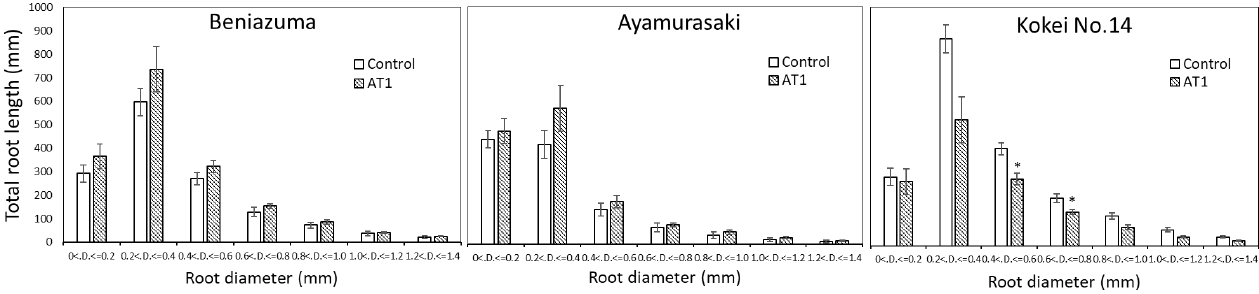
Figure 1. Effect of Bradyrhizobium sp. AT1 inoculation on root length of three cultivars of sweet potato. The length is shown separately for different diameter classes. * Significant differences between the inoculation treatments at the 95% confidence level as determined by Student’s t -test, n = 6. In containers filled with a mixture of vermiculite, Napura potting soil, and light- Table 3. Effect of Bradyrhizobium sp. AT1 inoculation on total plant dry weight of three cultivars of sweet potato grown in containers *. colored Andosol, the shoot dry weight of cv. Beniazuma was significantly